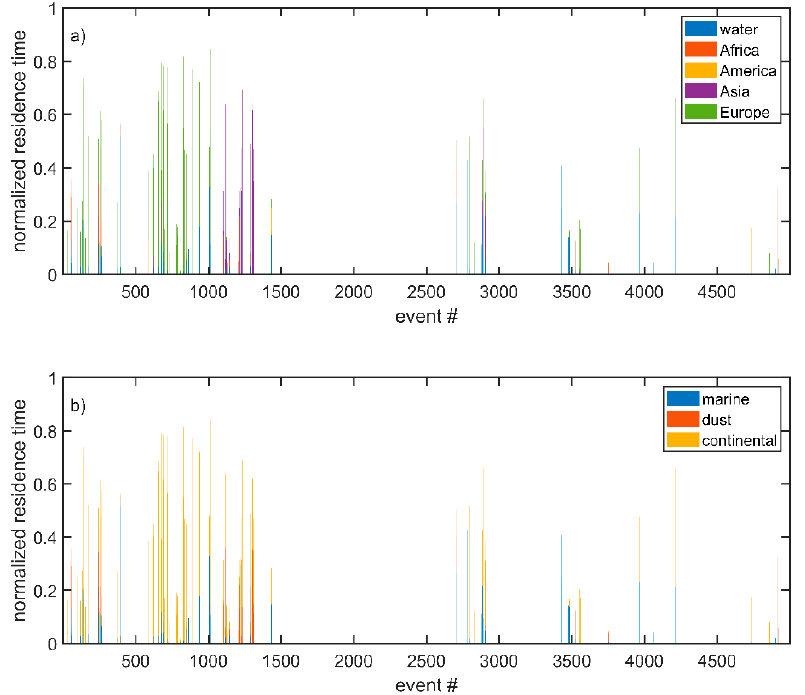
Figure A3. Same as Figure A2 for the heavy pollution events. Normalized residence time over continents ( a ) and the associated aerosol type ( b ) (‘outside climatology